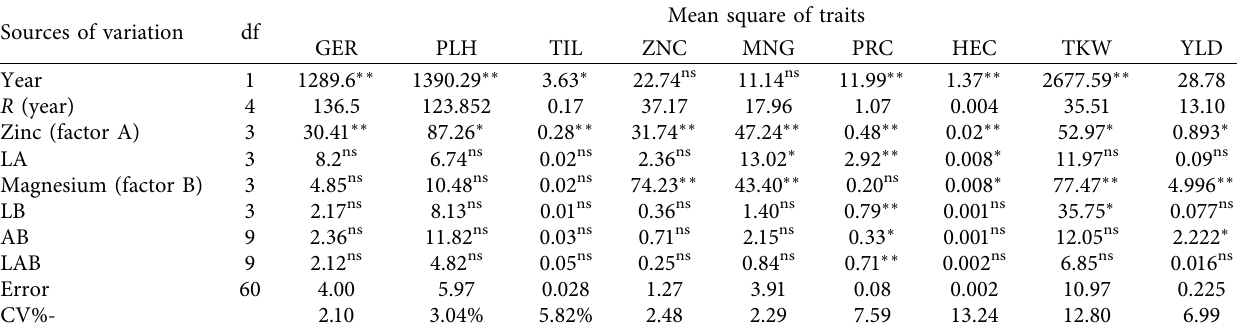
Mean square of traits